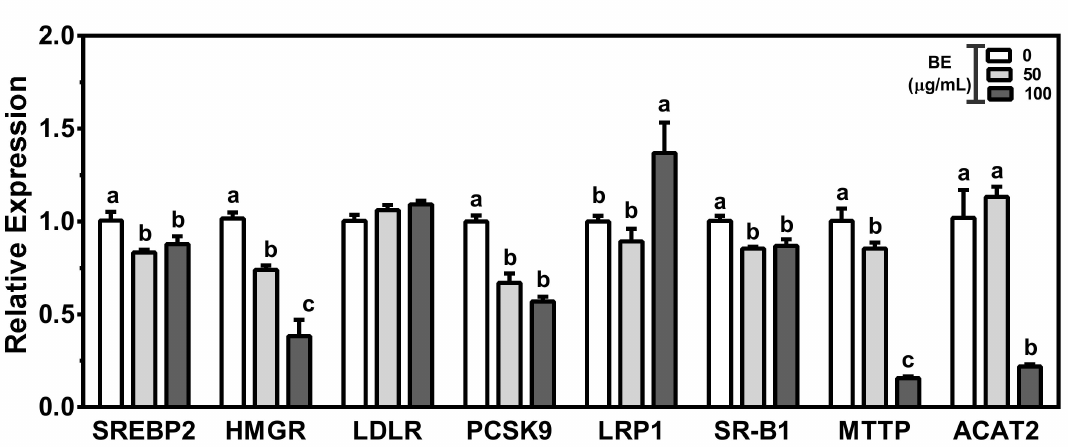
Figure 2. The effects of BE on the mRNA expression of genes involved in cholesterol de novo synthesis and uptake in HepG2 cells. Cells were treated with either 50 or 100 µ g/mL of BE for 24 h. The mRNA abundance was determined by qRT-PCR analysis. Bars with different letters are significantly different ( p < 0.05). Values are means ± S.E.M. n = 6.